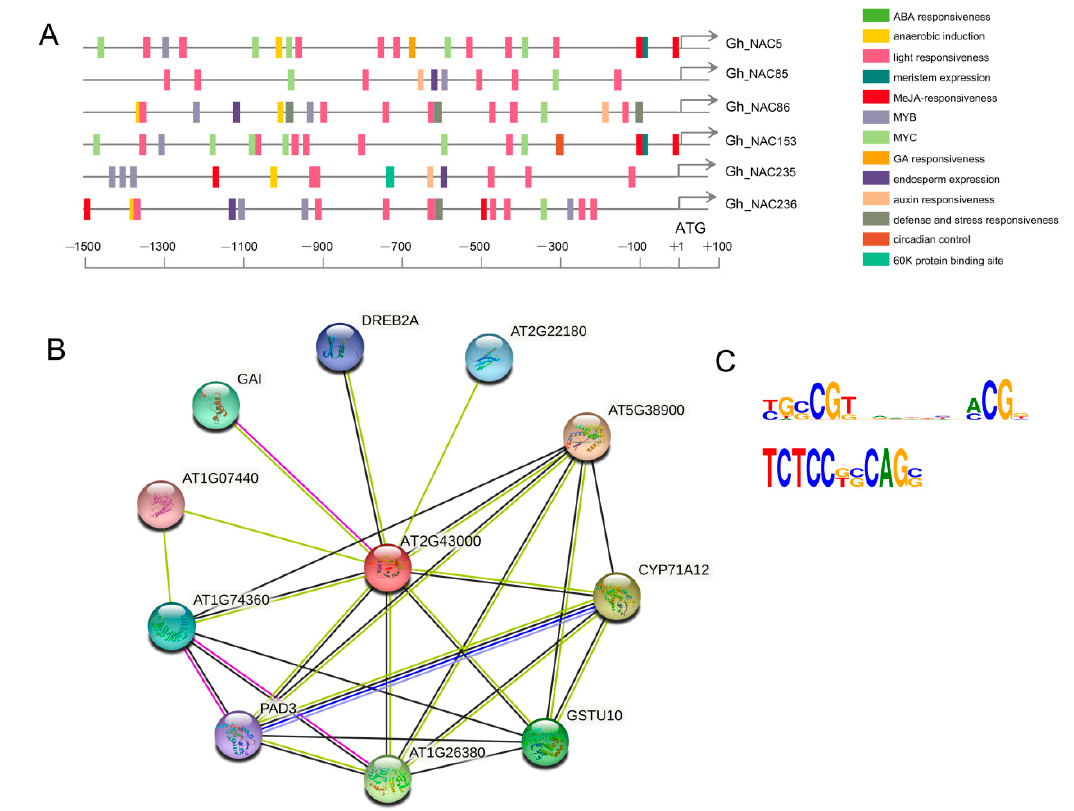
Figure 11. Predicted regulatory mechanism of 6 NAC genes. ( A ) Cis-elements analysis of 6 NAC gene promoters. ( B ) Predicted interaction network of 6 NAC proteins. ( C ) Putative binding motifs of 6 NAC proteins.